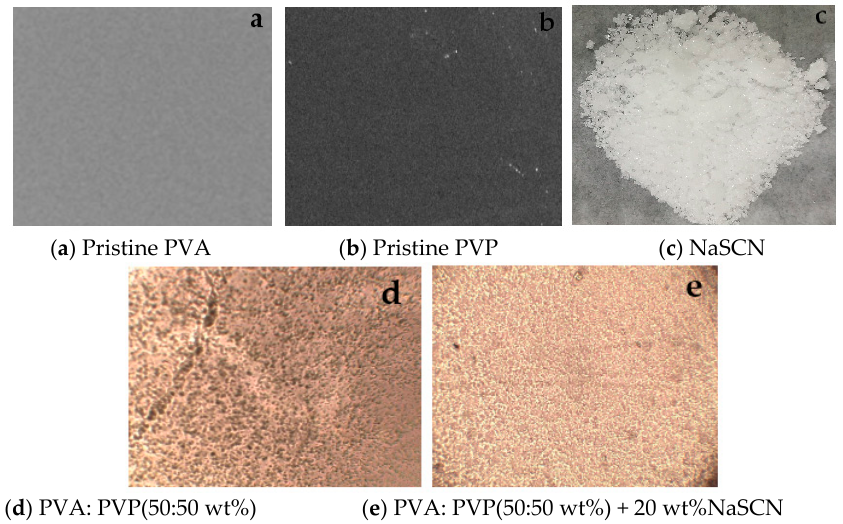
Figure 3. Micrographs of ( a ) pristine PVA film, ( b ) pristine PVP film, ( c ) NaSCN, ( d ) pure polymer blend PVA/PVP film, and ( e ) salt-based polymer blend electrolyte film recorded with (×10 magnifi- cations) and scale bar of 100 μ m.